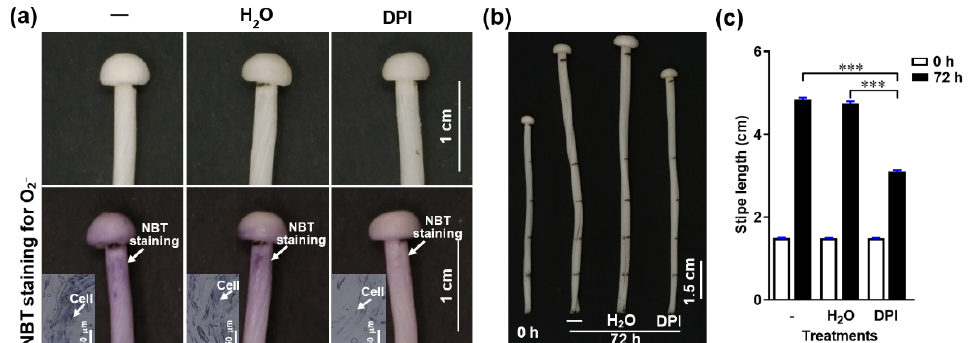
Figure 4. The effect of the NADPH oxidase inhibitor (DPI) on O 2 − production and stipe elongation. ( a ) The O 2 − detected by NBT histochemical staining after different treatments. The O 2 − is visualized as purple deposits with NBT (marked by white arrows). The inserts in the bottom row panels correspond to the histochemical staining on a cellular level. ( b ) Stipe elongation phenotype upon different treatments after 0 and 72 h cultivation.—corresponds to normal growth without any treatment, H 2 O means the stipe was soaked in water for 30 min, DPI means the stipe was soaked in 50 µ M DPI for 30 min. The junction between the pileus and stipe and each 1.5 cm region from the stipe apex to the base were labelled before treatment. ( c ) Stipe elongation of the ER measured at 0 and 72 h of cultivation after treatment.—corresponds to normal growth without any treatment, H 2 O indicates water treatment for 30 min, DPI indicates 50 μ M DPI for 30 min. The significance levels were calculated by paired t-test and marked as follows: *** p < 0.001, n = 50.